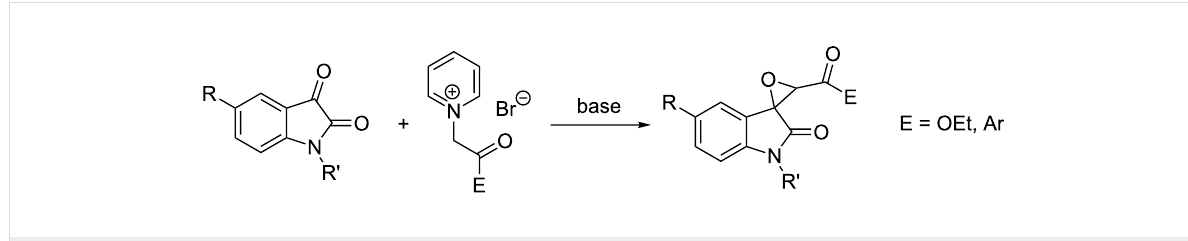
Table 1: Reaction of 5-methylisatin ( 1 ) with phenacyl bromide ( 2 ).